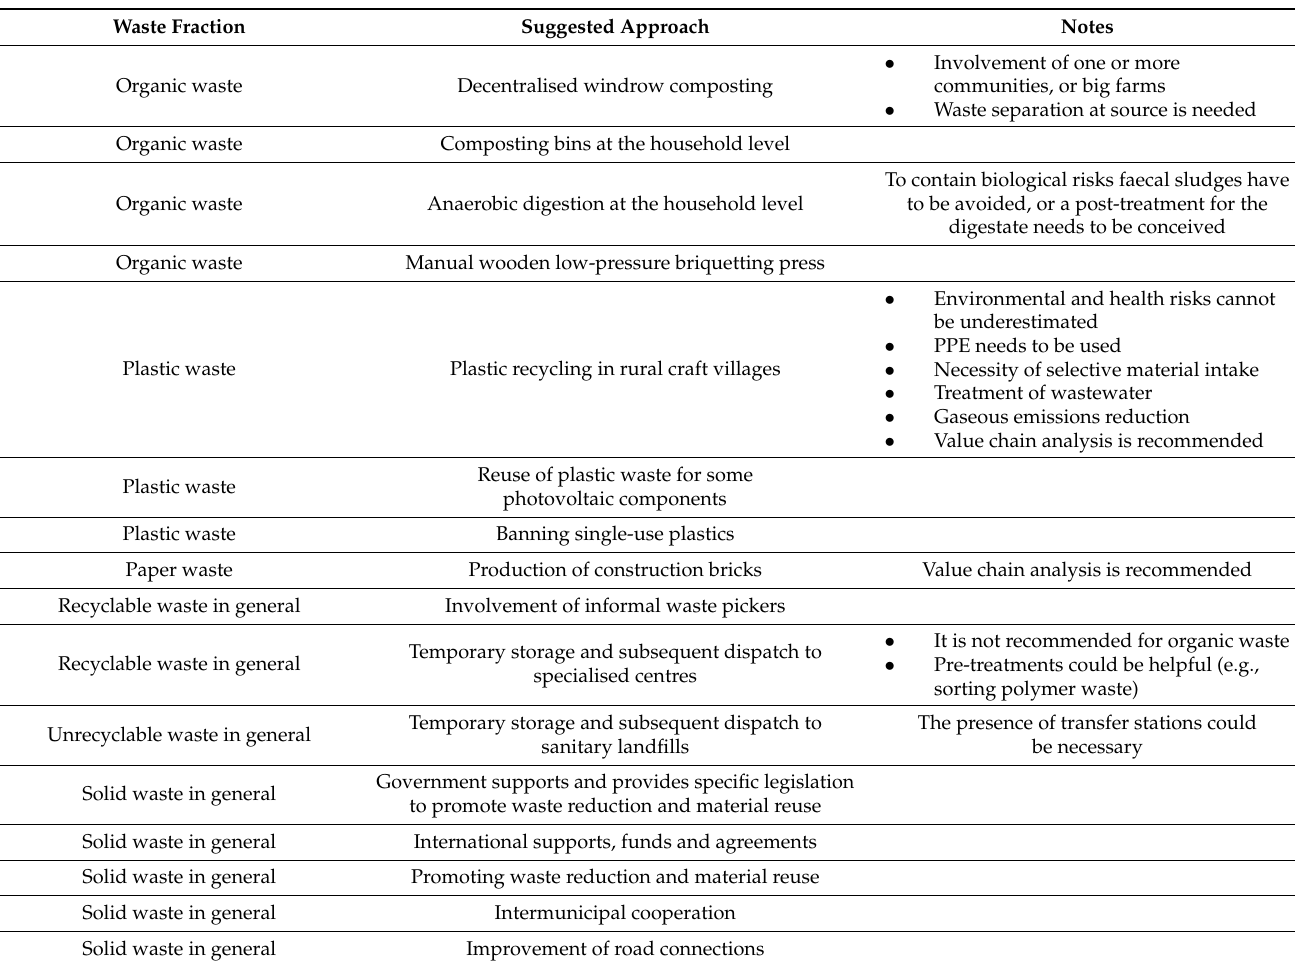
Table 3. Summary of the best approaches identified for rural communities of developing